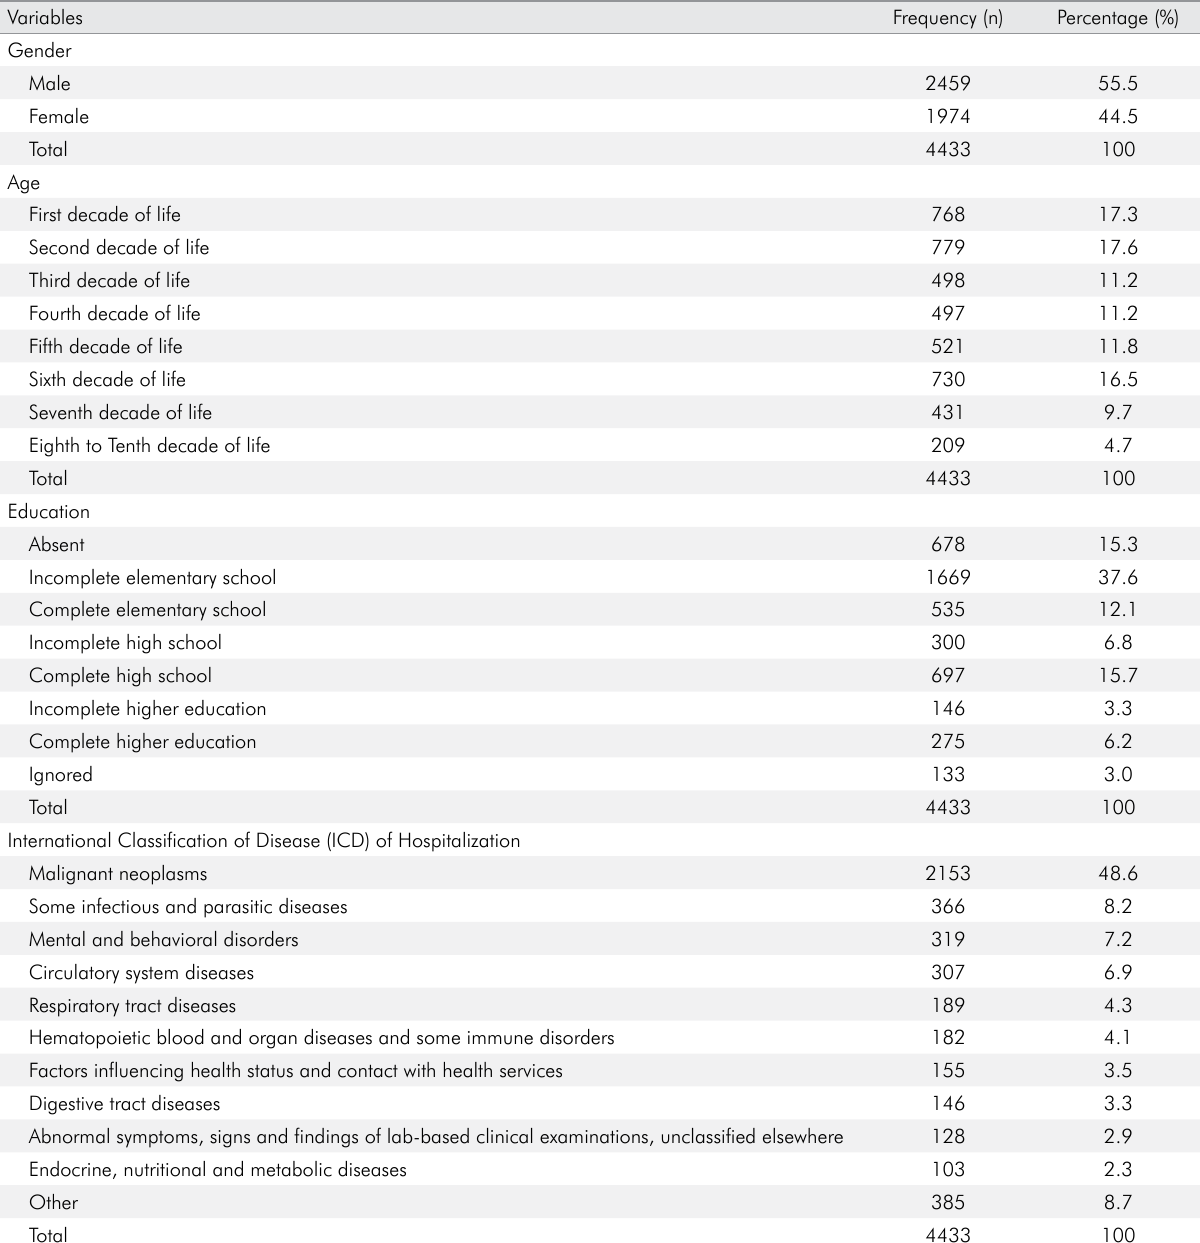
Table 1. Simple (n) and relative (%) frequencies of data related to the